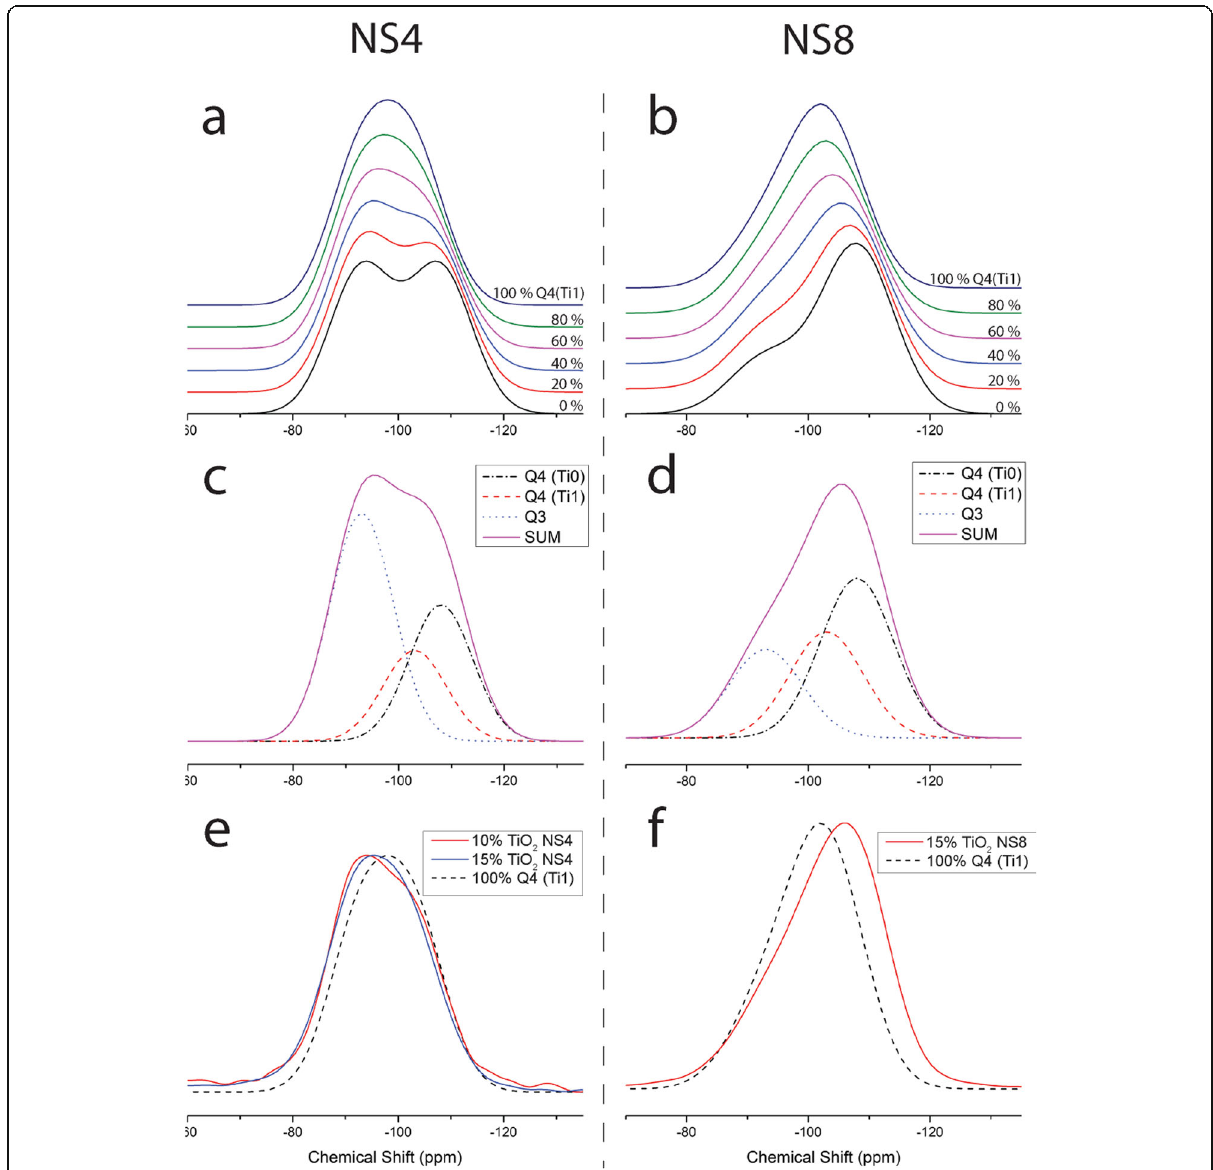
Fig. 8 Simulated 29 Si NMR spectra for Ti-bearing Na-silicate glasses, generated using Gaussian peaks at the positions and shapes of the Ti-free a NS4 and b NS8 glasses, by varying the proportions of Q 4 (Ti = 1) and Q 4 (Ti = 0) peaks. The peaks that compose these model spectra at 40% Q 4 (Ti = 1) and 60% Q 4 (Ti = 0) are shown in 8 c and 8 d . Increasing Ti content in the simulations is represented by the growth of a third Q 4 peak at a higher frequency as a result of nearest-neighbor interactions with [4] Ti nearest neighbors. The simulations are similar to the actual spectra, with the notable difference that the simulations over-estimate the amount of Q 4 Si with [4] Ti nearest neighbors Q 4 (Ti = 1). e , f If Ti was incorporated entirely by the Q 4 (Ti = 1) mechanism, then observed spectra would be reflective of 100% Q 4 (Ti = 1) at high Ti content in NS4 and NS8 glasses. However, NS8 glass with 15 mol% TiO2 and NS4 glass with 10 and 15% TiO2 which would have all Si in Q 4 (Ti = 1) at these concentrations are still significantly far from Q 4 (Ti = 1). This over-estimation suggests that Ti is clustering at relatively low bulk TiO 2 , an observation that is supported by the Ti XAFS observations of significant [5] Ti in the NS8